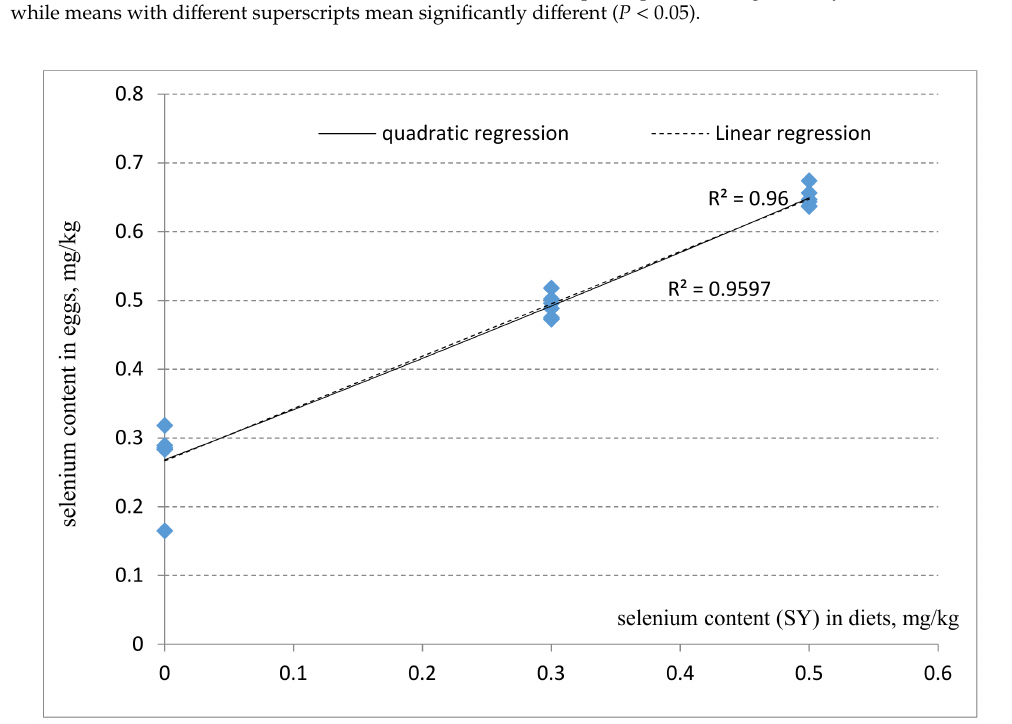
Figure 1. Linear and quadratic regression of egg selenium content (mg / kg) of laying hens on supplemental di ff erent level of yeast selenium (mg / kg).